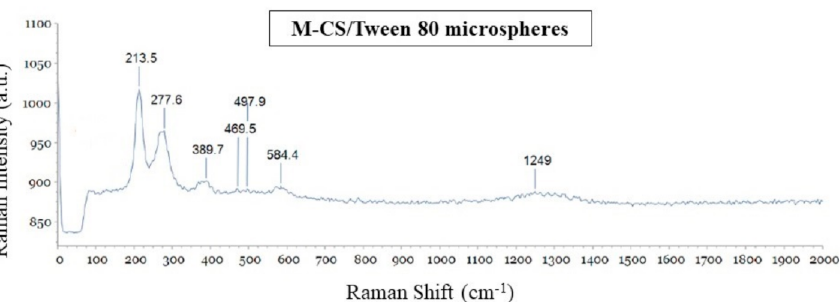
Figure 3. Raman spectrum of chitosan/Tween 80 microspheres loaded with magnetite nanoparticles (M-CS/Tween 80).